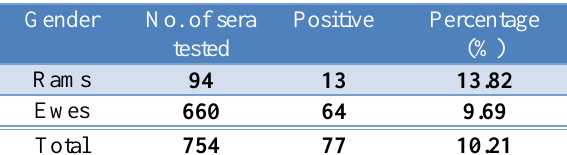
Table, 2: Rate of infection of sheep brucellosis by using RBPT according to gender